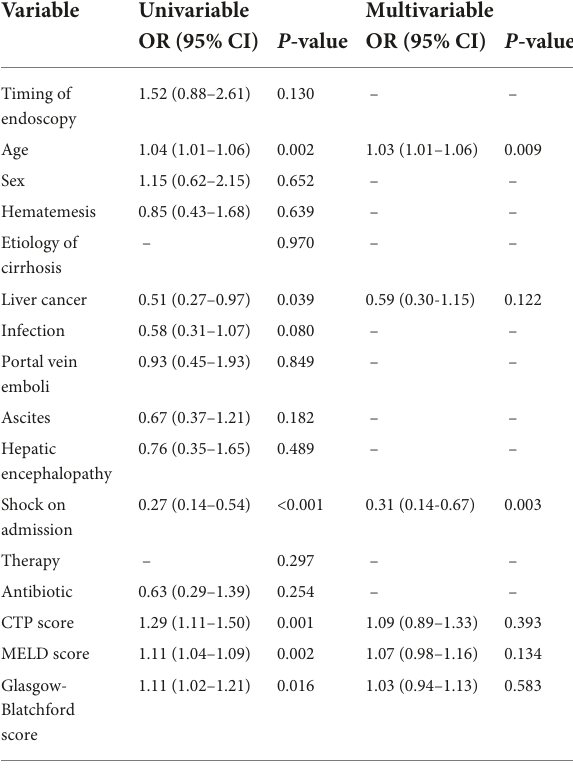
TABLE 5 Univariate and multivariate logistic regression analyses of the composite outcome of 30 days rebleeding and mortality. Variable